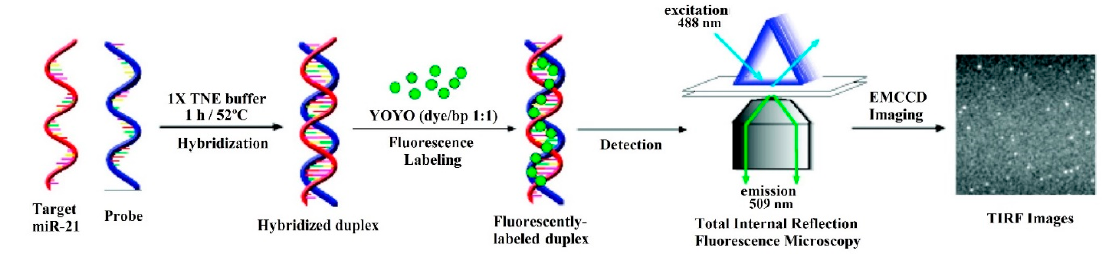
Figure 2. Schematic illustration of the hybridization-based total internal reflection fluorescence microscopy (TIRFM) assay for the detection of single miR-21 molecules in solution in which the fluorophore YOYO-1 is used. Reproduced with permission from [42]. Copyright 2010 American Chemical Society.